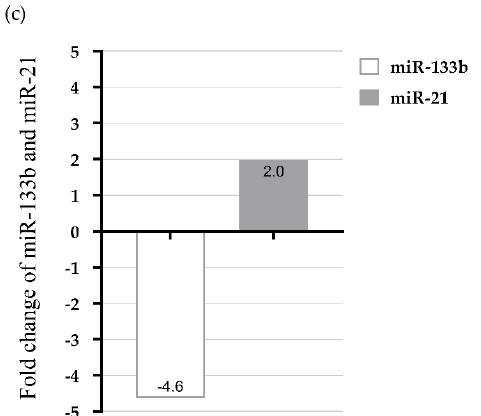
Figure 1. Quantitative real-time (qRT–PCR) analysis to find out variations in gene expression (delta-CT values) of miR-133b and miR-21 in the study subjects: ( a ) Differential gene expression (delta-CT values) of miR-133b in CAD patients ( n = 78) vs. control subjects ( n = 50). ( b ) Differential gene expression (delta-CT values) of miR-21 in CAD patients ( n = 62) vs. control subjects ( n = 54). Results were expressed as mean ± SD; ( c ) Relative fold changes of miR-133b and miR-21 in CAD patients